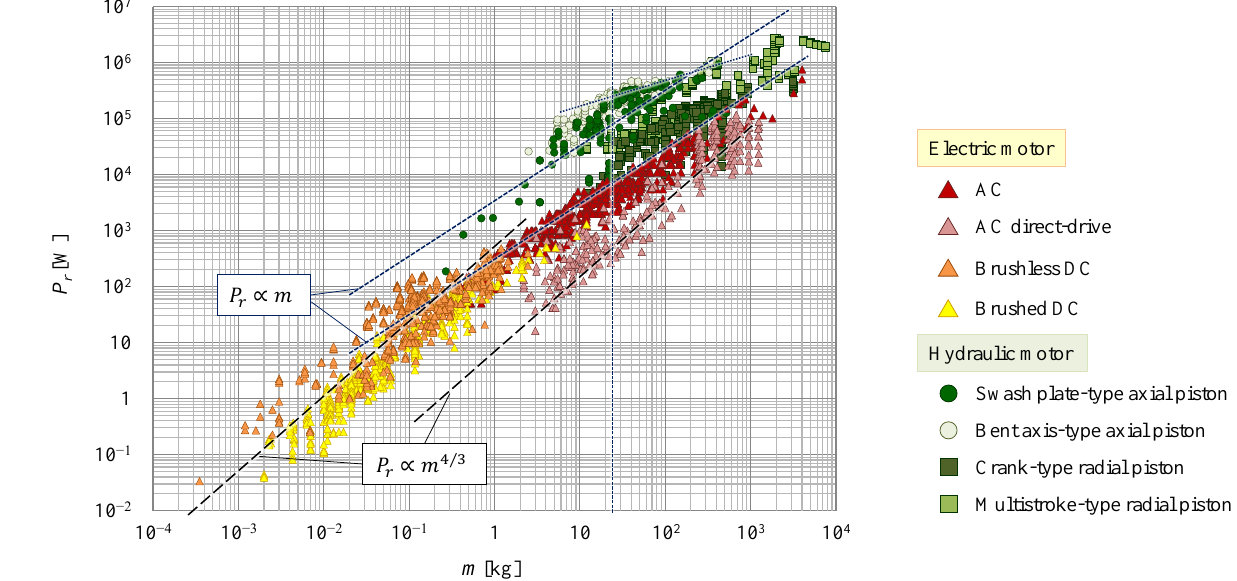
Figure 10. Correlation between motor weight and rated output power.